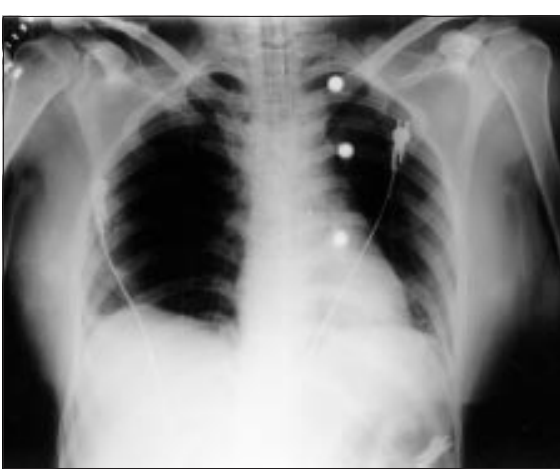
Fig. 10 –Radiografia de tórax em PA no pós-operatório com área cardíaca